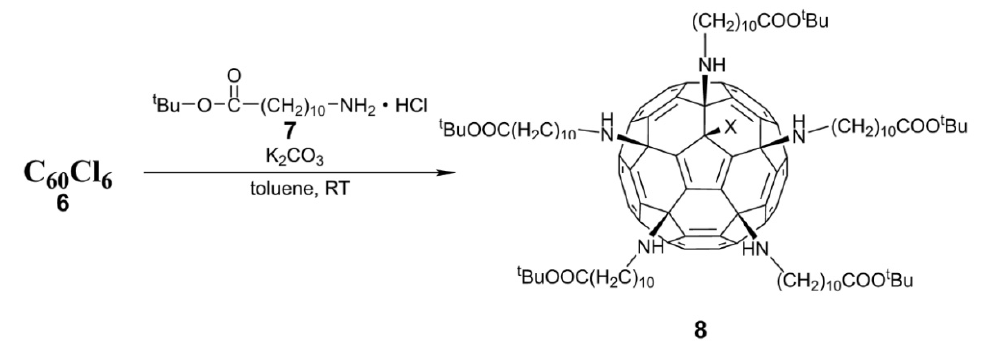
Figure 6. Synthesis route of fullerene amino ester derivative ( 8 ).